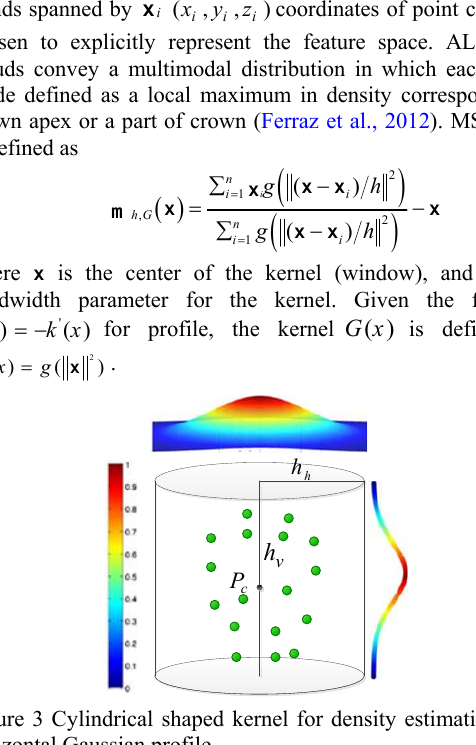
Figure 3 Cylindrical shaped kernel for density estimation with horizontal Gaussian